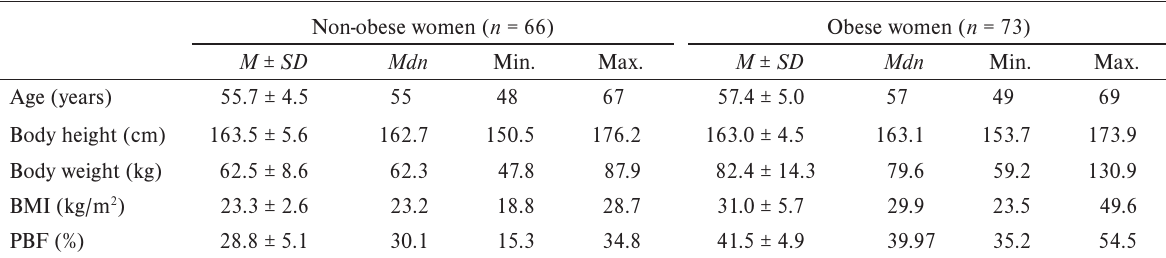
Age and somatic parameters in non-obese and obese women Non-obese women ( n = 66)